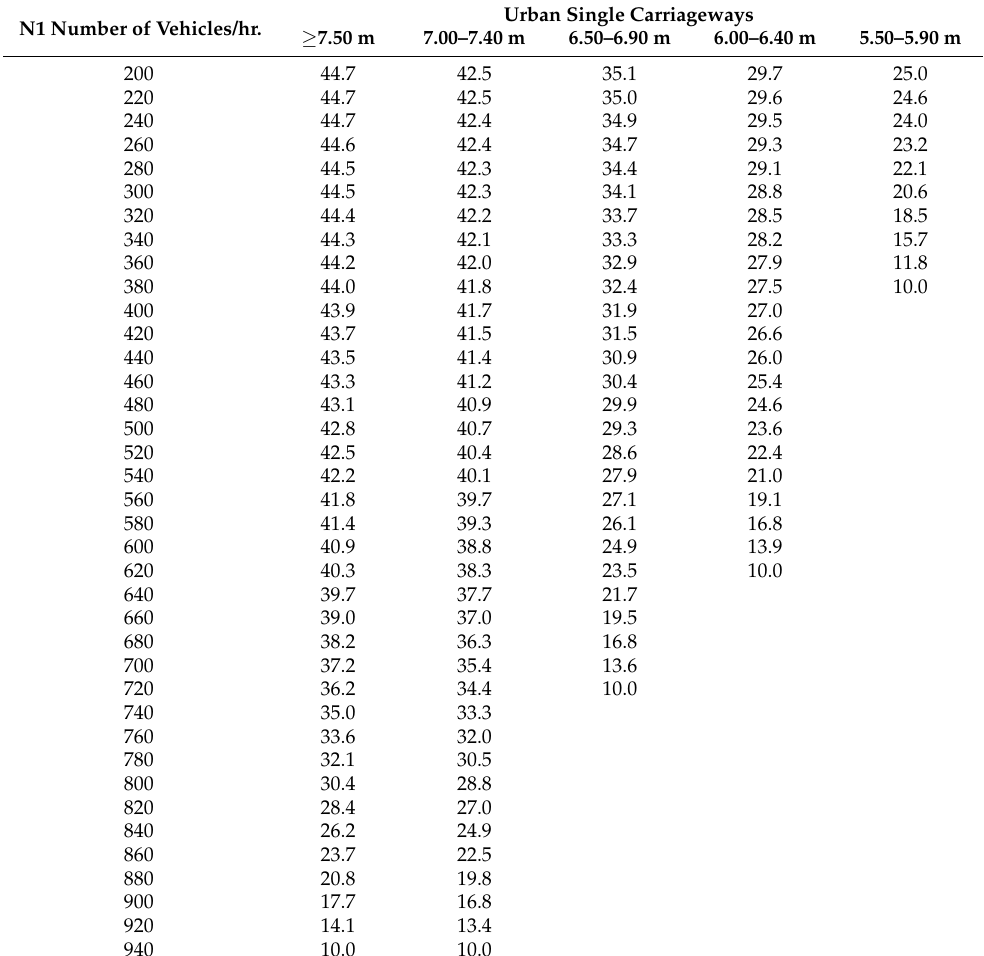
Table A2. Cont. N1 Number of Vehicles/hr.